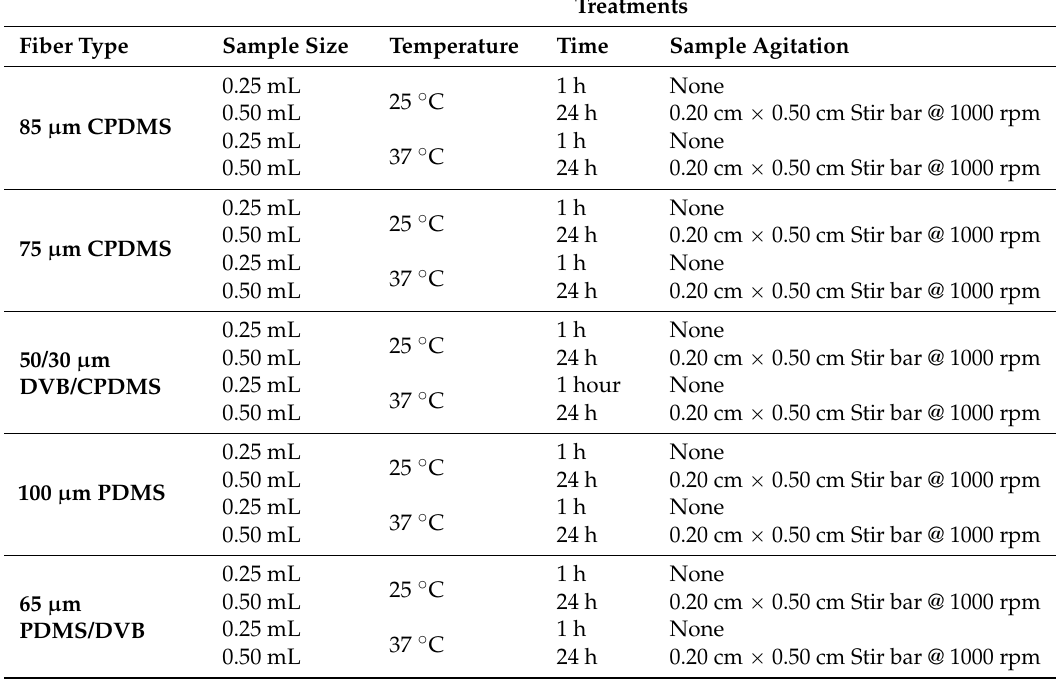
Table 3. Experimental treatments and the different fiber types used in the experimental design.